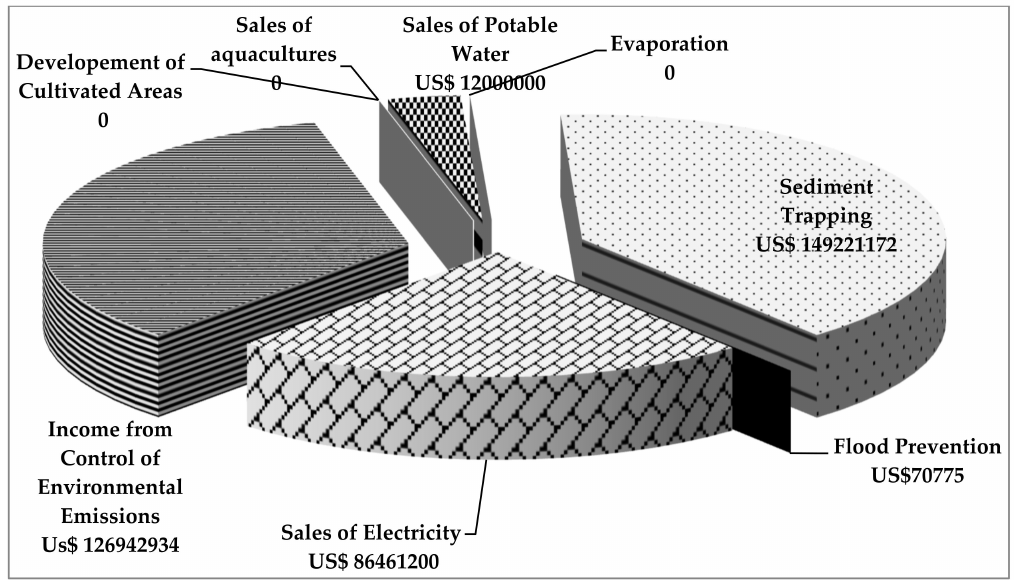
Figure 2. Net revenue of Bakhtiari